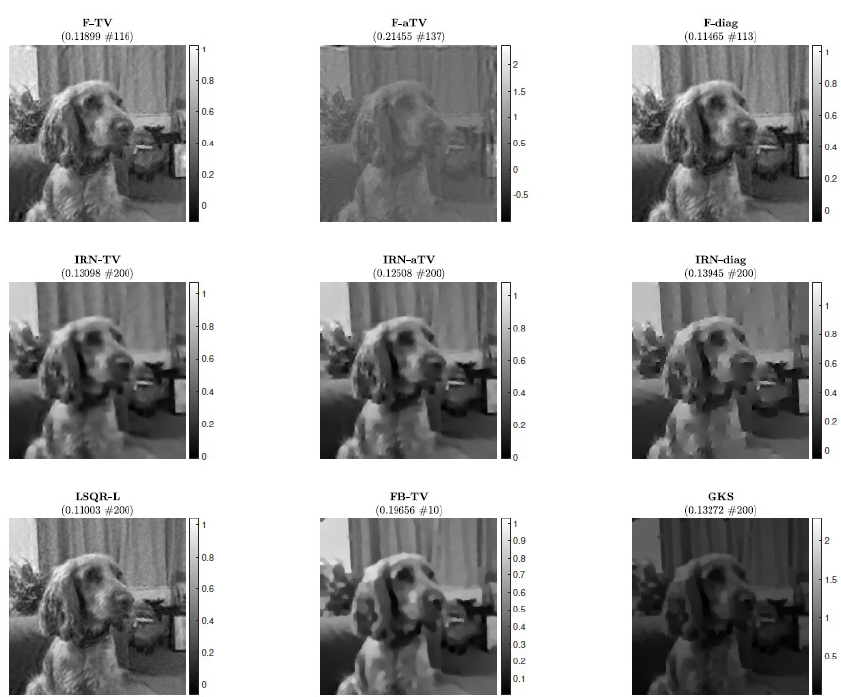
Figure 7. Experiment 2. Reconstructions achieved by various methods. The RRE and stopping iteration for each reconstruction are displayed in the frame